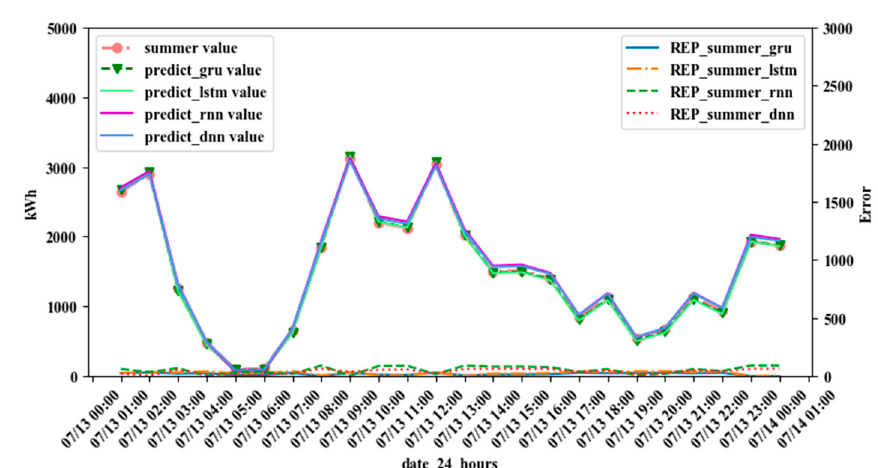
Figure 9. Predictions and REP of the summer scenario.